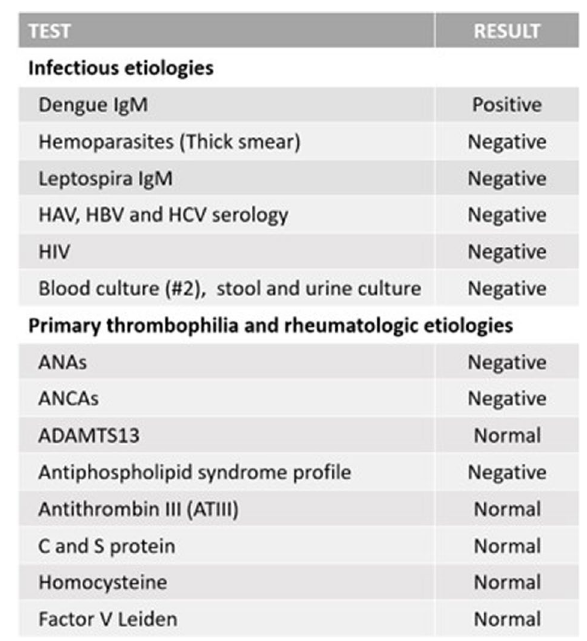
Table 2 Prothrombotic state and acute non-cirrhotic portal vein thrombosis etiologies ruled